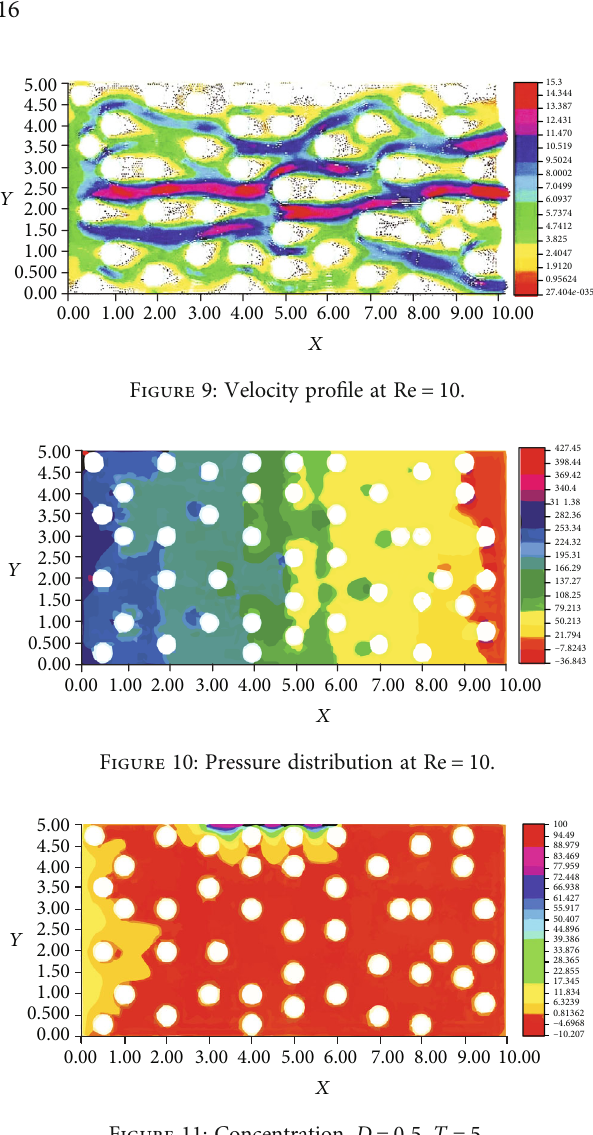
Figure 11: Concentration, D = 0 : 5 , T = 5 .